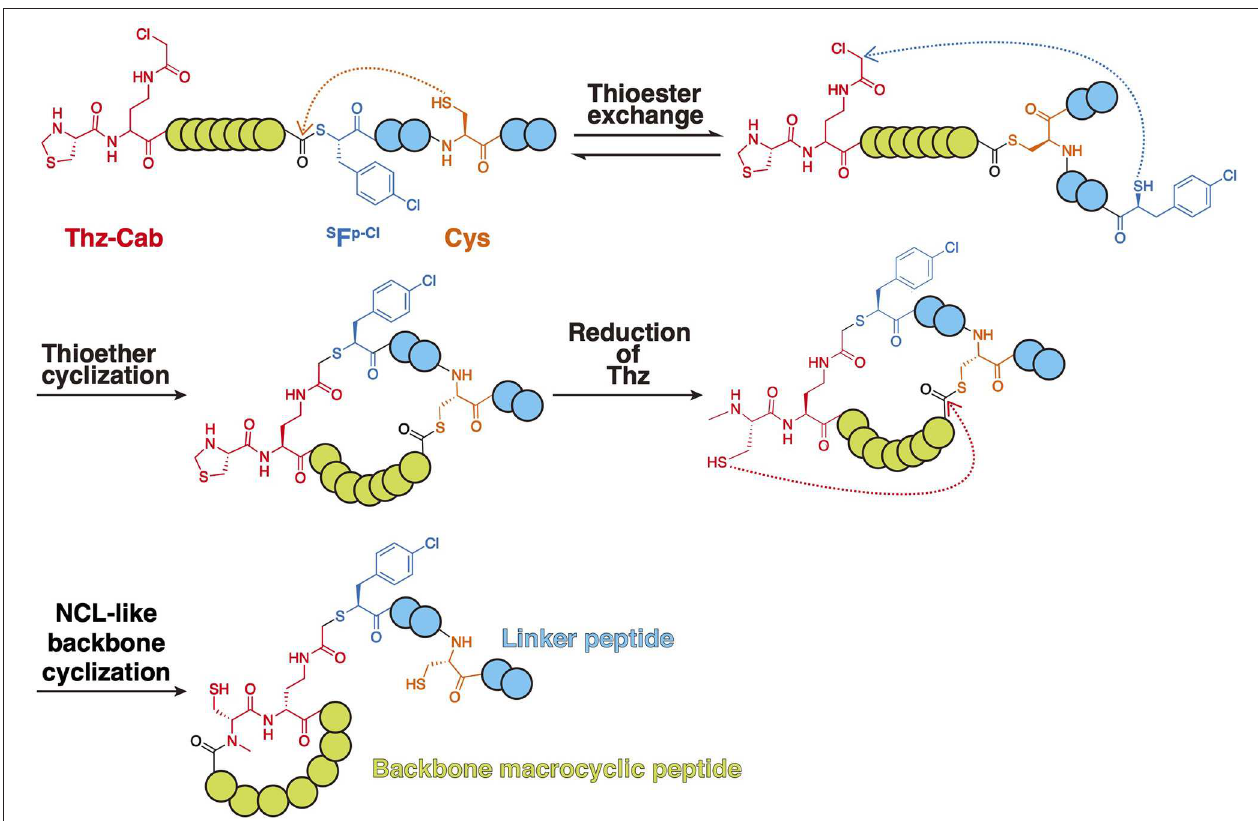
FIGURE 12 | Synthesis of backbone macrocyclic peptides compatible with mRNA display. A linear peptide containing Thz-Cab, HS F p − Cl , and subsequent Cys was transcribed by employing a genetic code reprogramming system. After spontaneous thioester exchange between the thioester and Cys, the resulting linear peptide spontaneously cyclized between the thiol Cab residue. Then, reduction of Thz by NaBH 3 CN produced N- methyl Cys, which provoked NCL-like backbone cyclization. Green circles show potential backbone macrocyclic peptide. Blue circles show linker